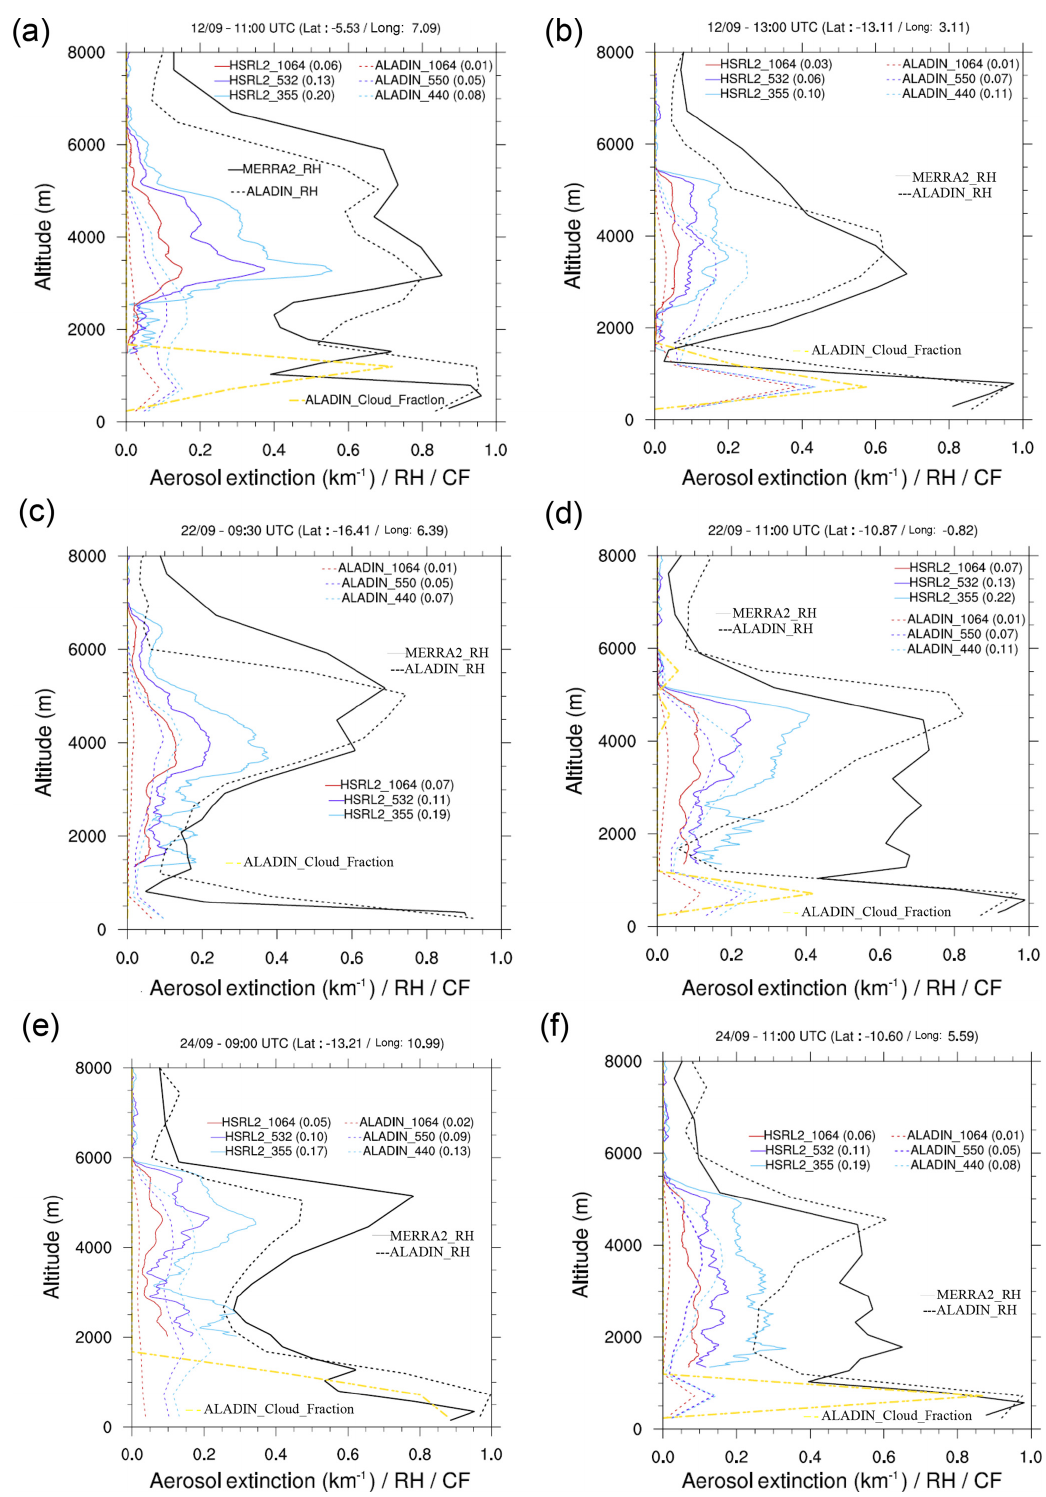
Figure 8. Vertical profiles of aerosol extinction coefficient (in km − 1 ) at three different wavelengths from ALADIN-Climate and HSRL-2 instrument (red: 1064nm; purple: 550nm; blue: 440nm), associated with the mean values (note that the wavelengths are not exactly similar, especially in ultraviolet). Also reported are the vertical profiles of RH simulated by ALADIN-Climate (dotted black) and MERRA-2 (black), as well as the ALADIN-Climate cloud fraction (dotted